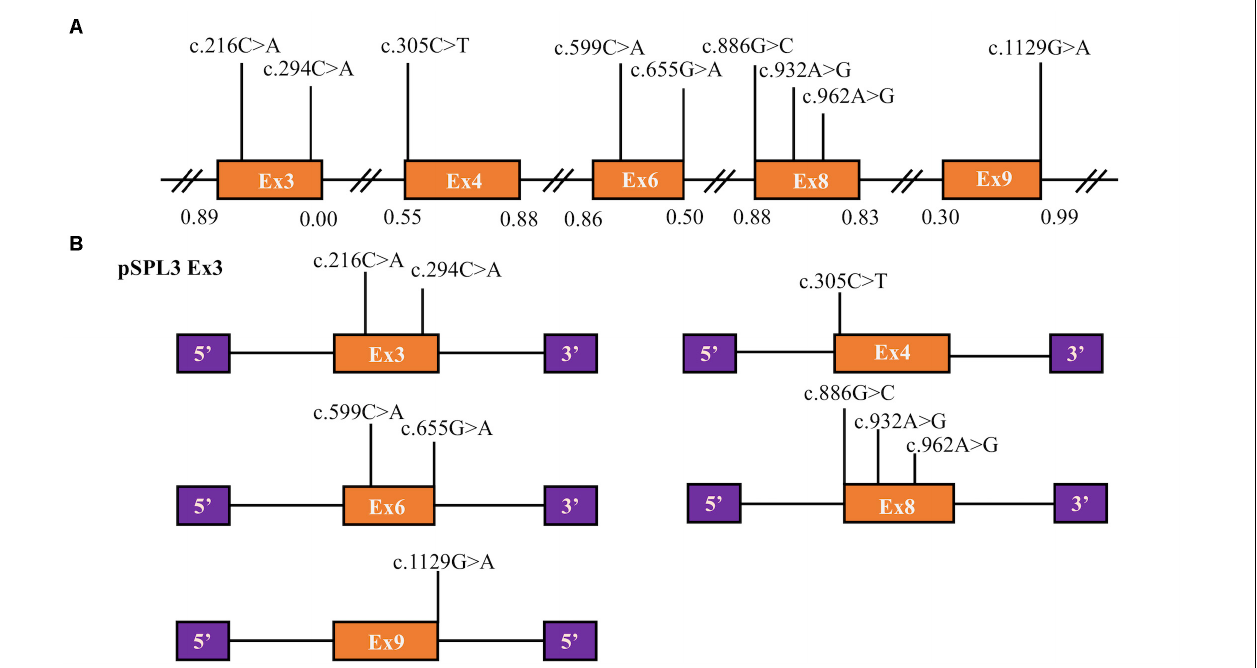
FIGURE 1 | Position of presumed missense variants that we analyzed and the schematic diagram of SLC5A2 minigenes. (A) Orange boxes and black lines between them represent the coding exons and introns sequences, respectively. Their sizes are out of proportion. The BDGP scores of donor and acceptor splice sites are represented in decimal. (B) Schematic representation of five minigenes constructed by pSPL3 vector and SLC5A2 wild-type sequences (orange boxes) including exon 3 (pSPL3 Ex3), exon 4 (pSPL3 Ex4), exon 6 (pSPL3 Ex6), exon 8 (pSPL3 Ex8) and exon 9 (pSPL3 Ex9), respectively. Purple boxes depict 5 (cid:48) and 3 (cid:48) exons of pSPL3 vector. Black lines indicate intron